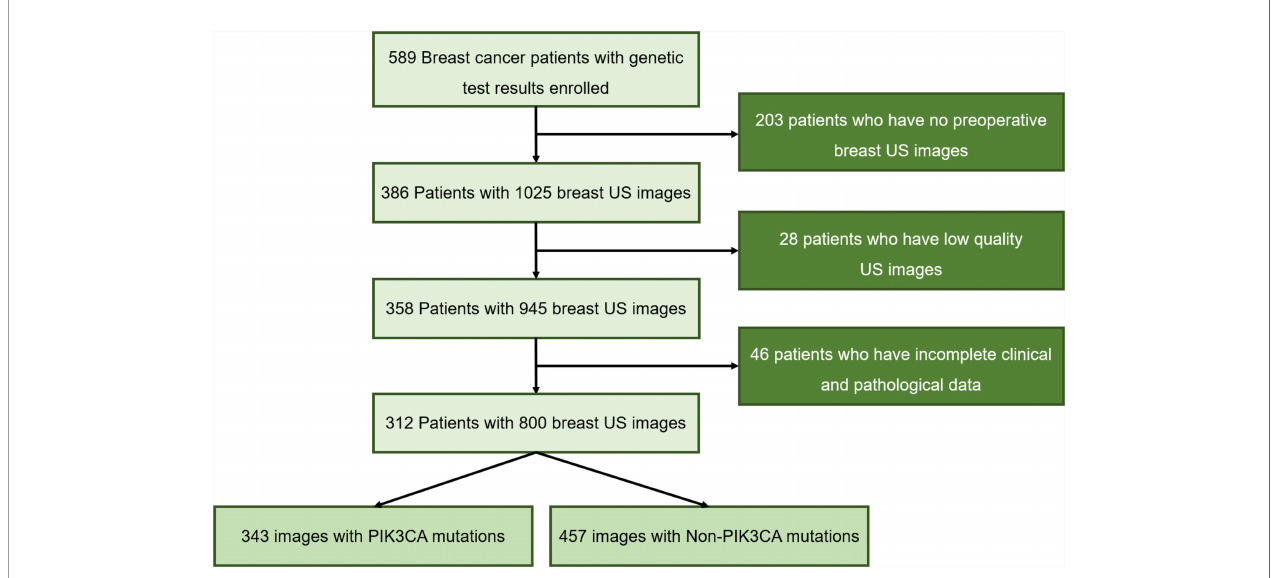
FIGURE 1 | Flowchart of the study cohort